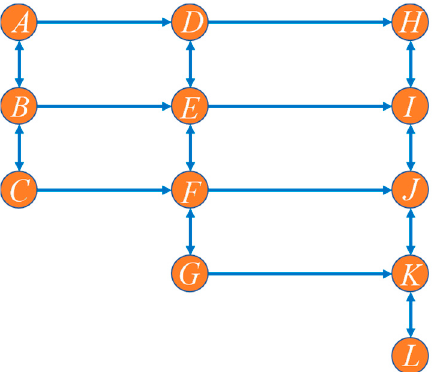
Figure 7. A lane group is shown, which comprises three lane sections that contain three, four, and